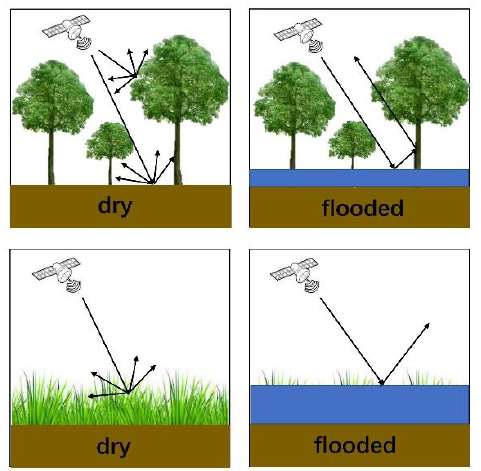
Figure 2. Backscattering characteristics of tall and short vegetation land covers under dry and flooded conditions.